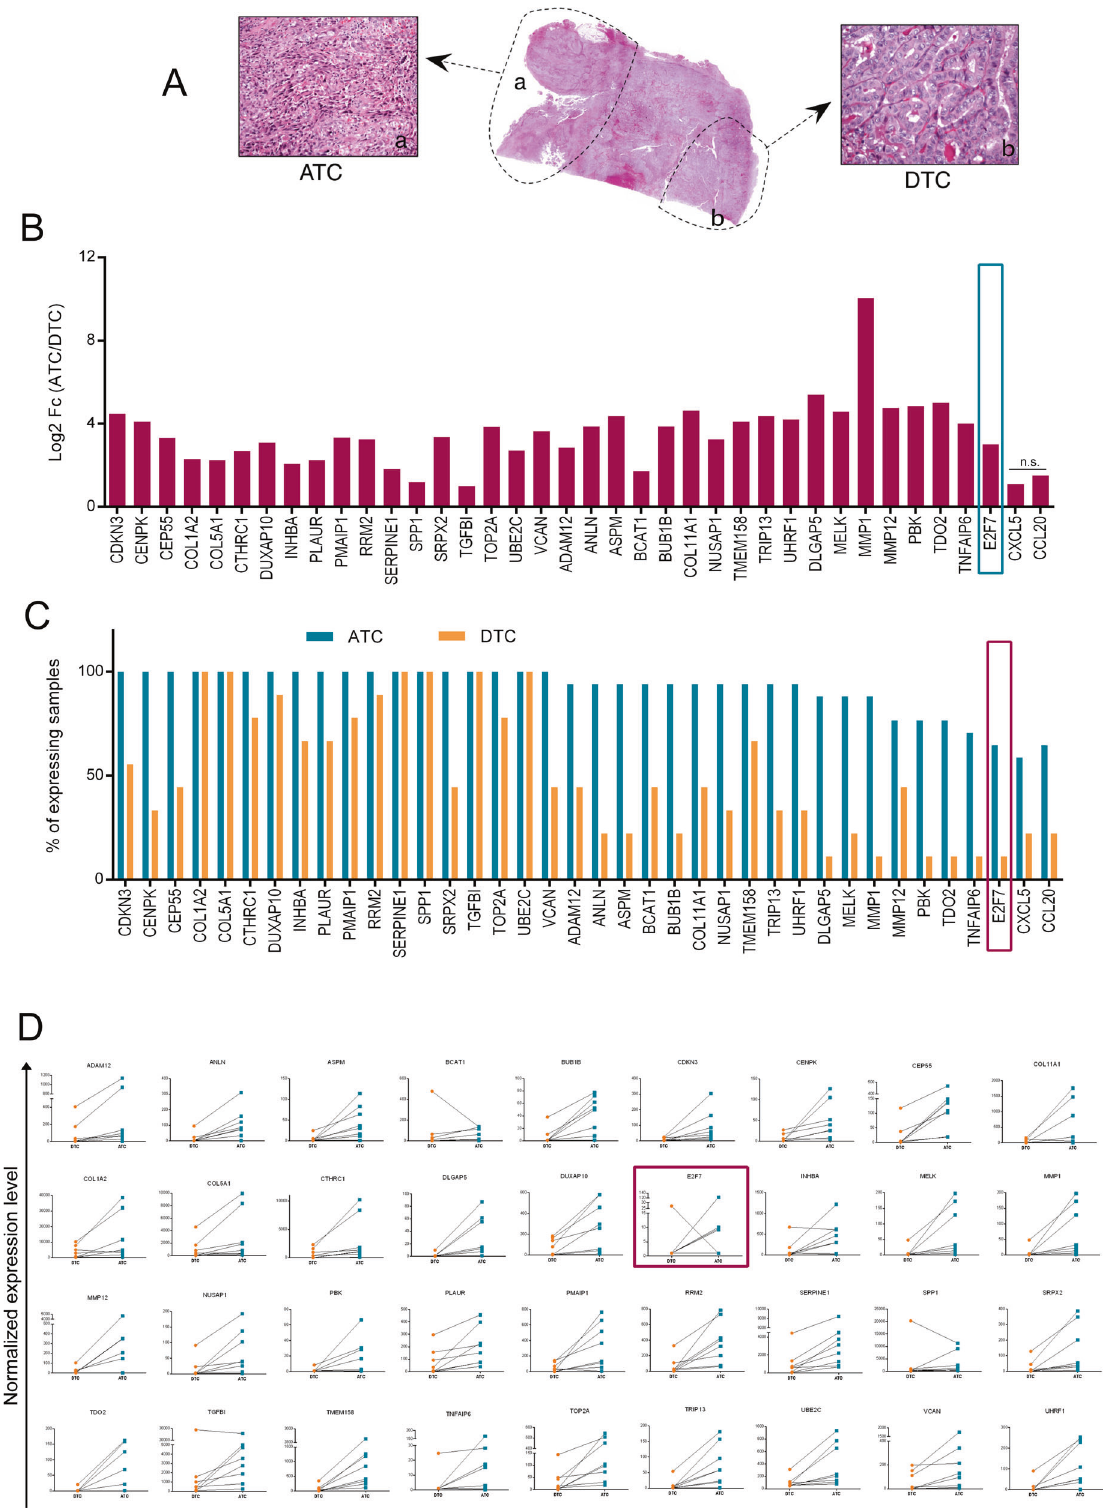
Fig. 2 In vivo validation of Trend UP S2 and S3 signatures in ATC patients. A Representative example of components separation in ATC mixed samples used for the analysis. B Gene expression analysis of Trend Up S2 and S3 genes in ATC samples. The bars represent the Fold Change (log2) of the difference between gene expression in ATC and in DTC. All the values are statistically signi fi cant (adjusted p -value < 0.05) except where “ n.s. ” is reported. C Percentage of samples (ATC and DTC) expressing the genes validated through Nanostring. D Normalized expression levels of indicated genes in matched ATC and DTC from the same patient. The expression of each gene in the indicated tissues is normalized on 4 housekeeping genes.